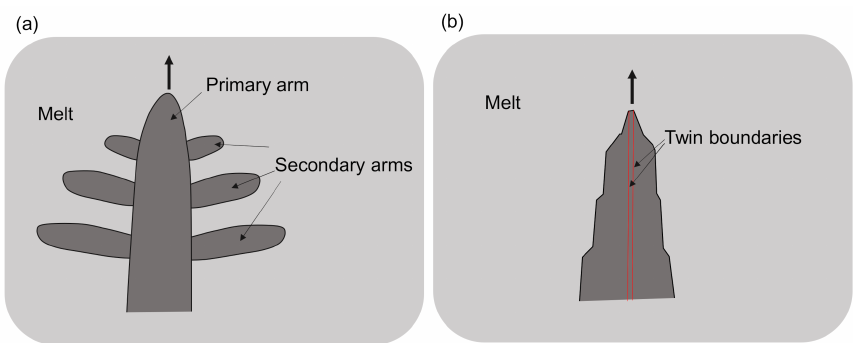
Figure 1. Growth shape of dendrites of ( a ) metallic alloys and ( b )